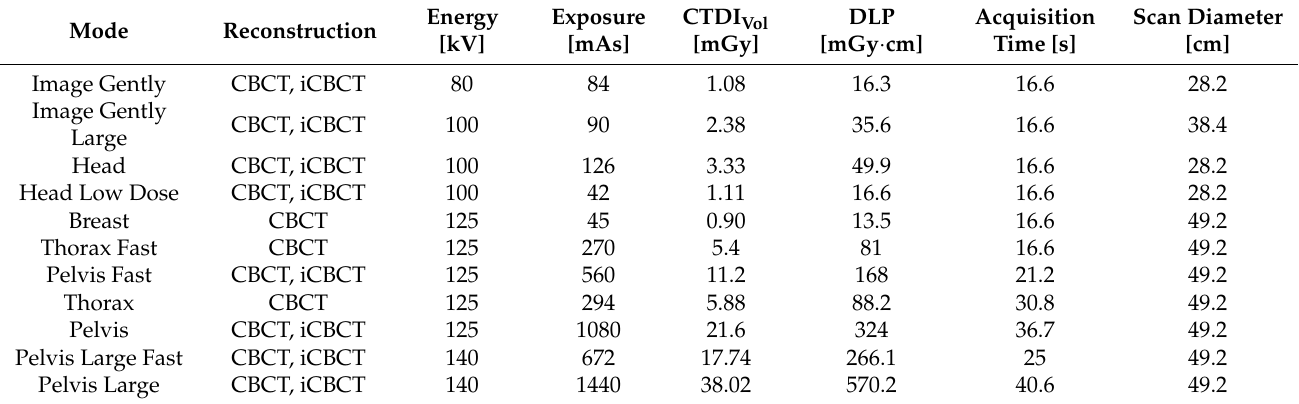
Table 1. CBCT and iCBCT acquisition parameters for the Halcyon accelerator [46]; CTDI Vol denotes volume computed tomography dose index, and DLP means dose length product.